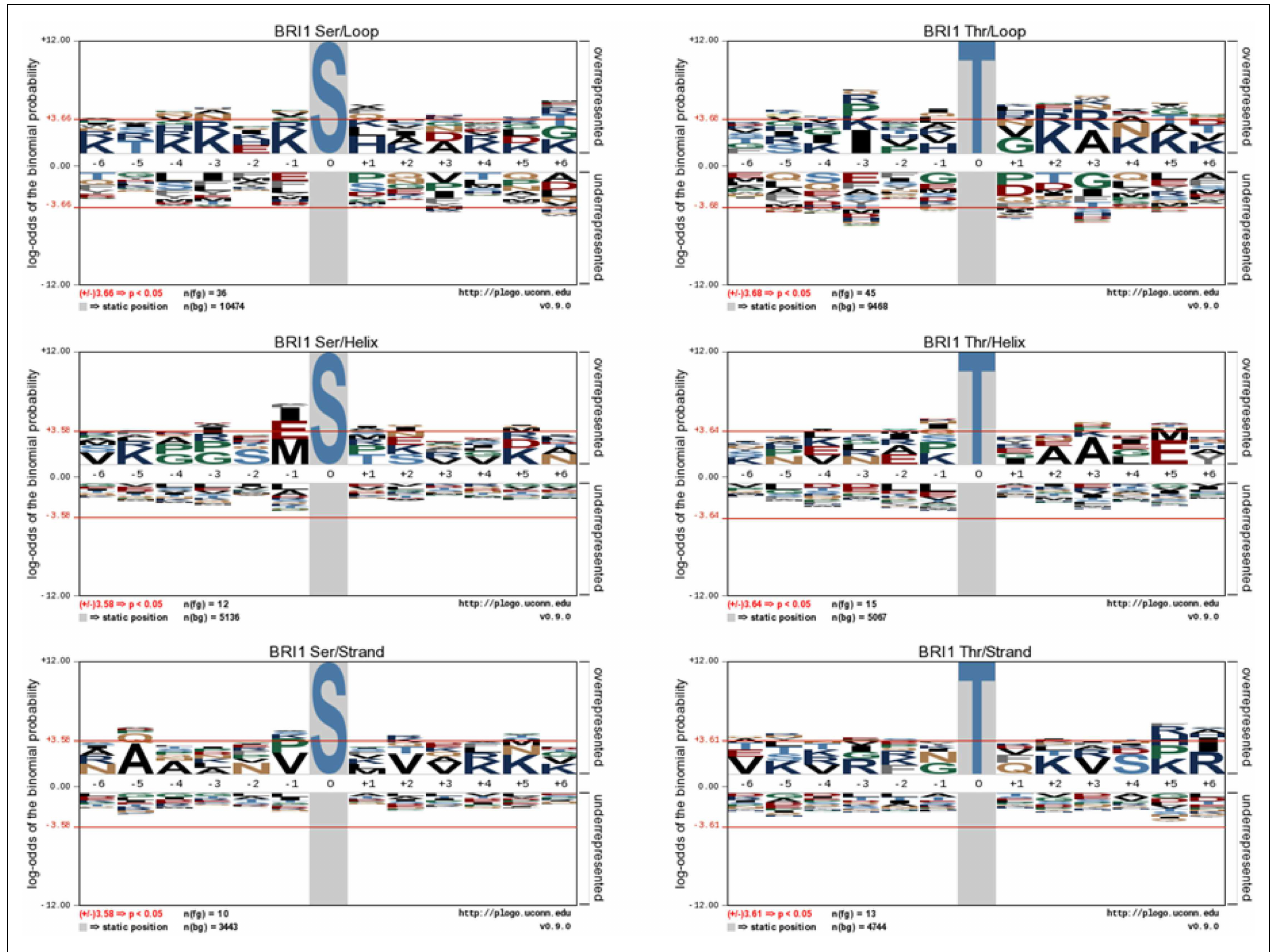
background database in E. coli proteome was used.The results revealed the distinct motif of loop substrates versus helix and strand substrates targeted by